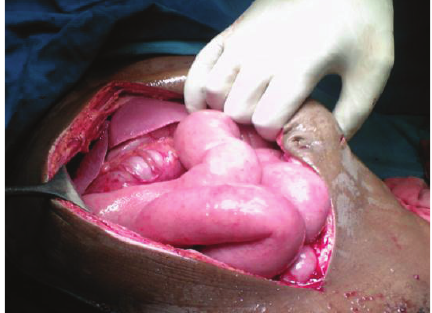
Figure 3: On opening the peritoneal sac the small bowel was noted to be free of adhesions and fully